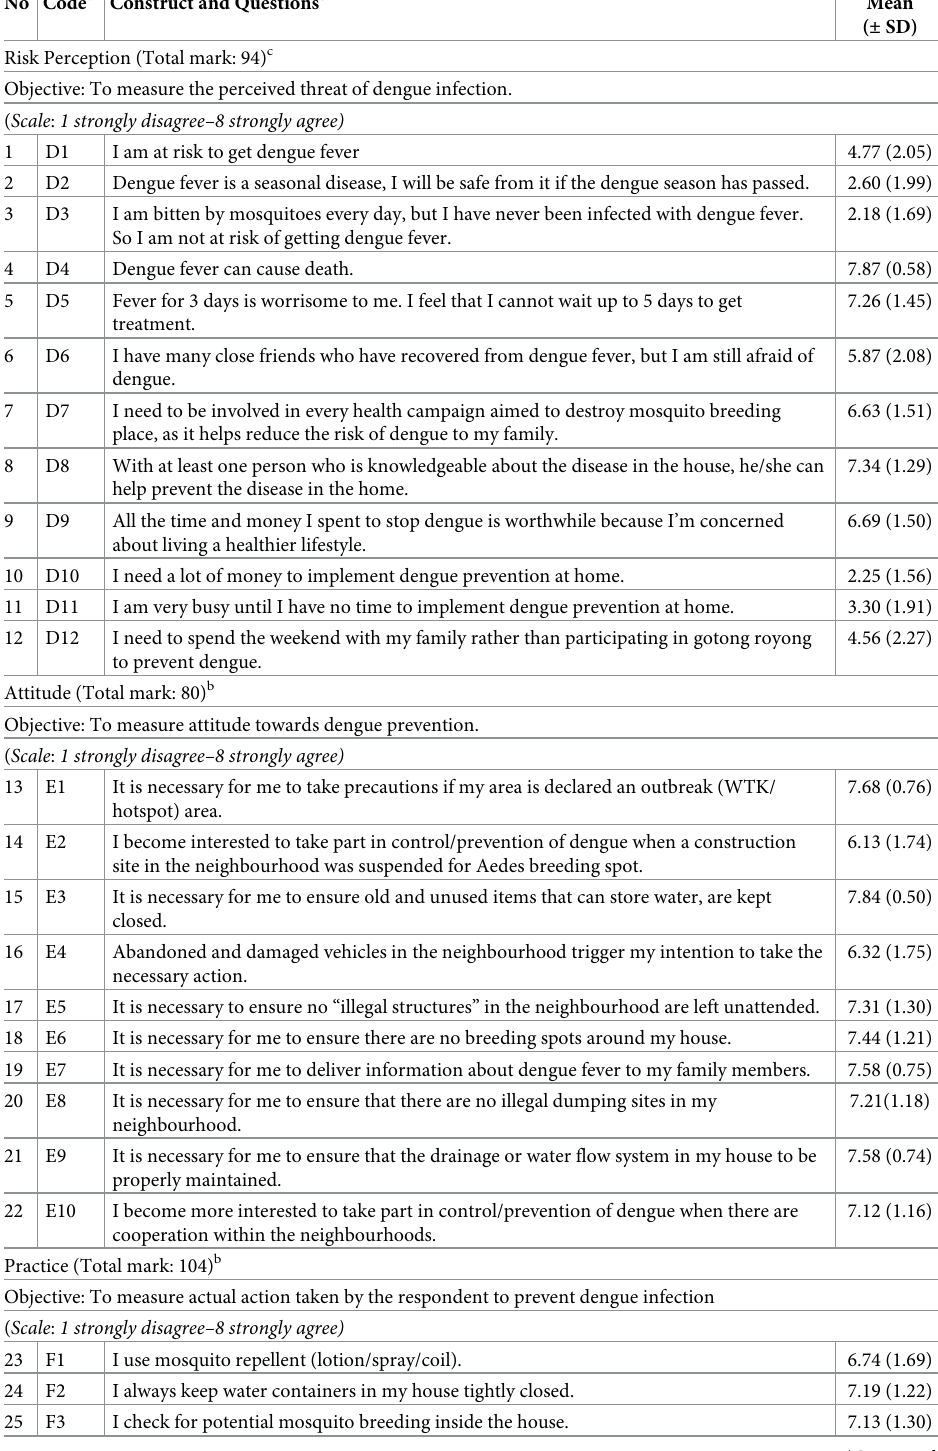
Table 2. Details of the items, constructs and the corresponding questions’ mean marks of each question, con- struct, and overall score (N = 253) based on the initial questionnaire development categories of risk perception, attitude, and